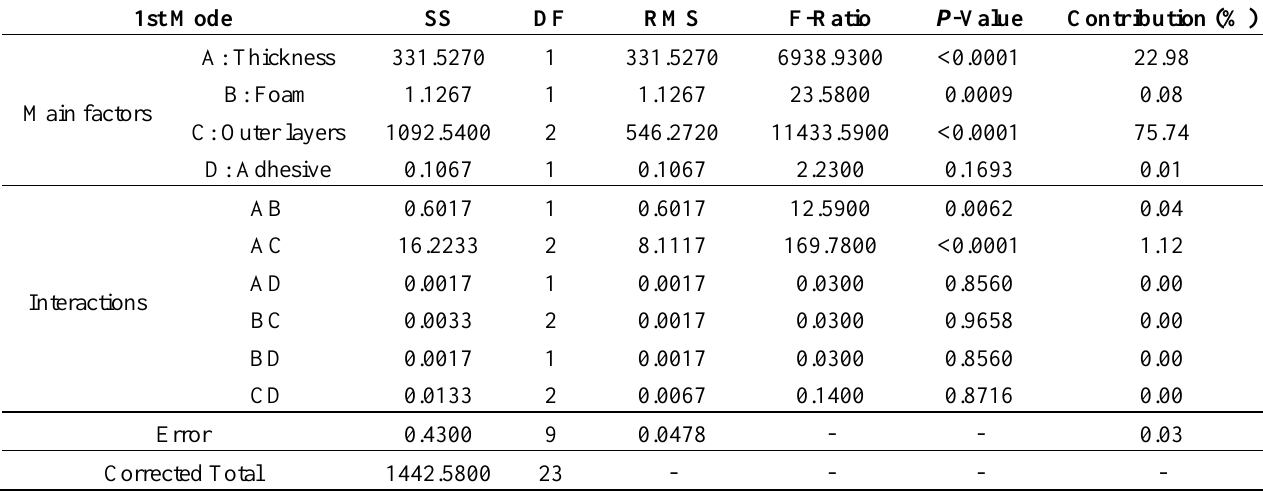
Table 6. 1st Mode: analysis of